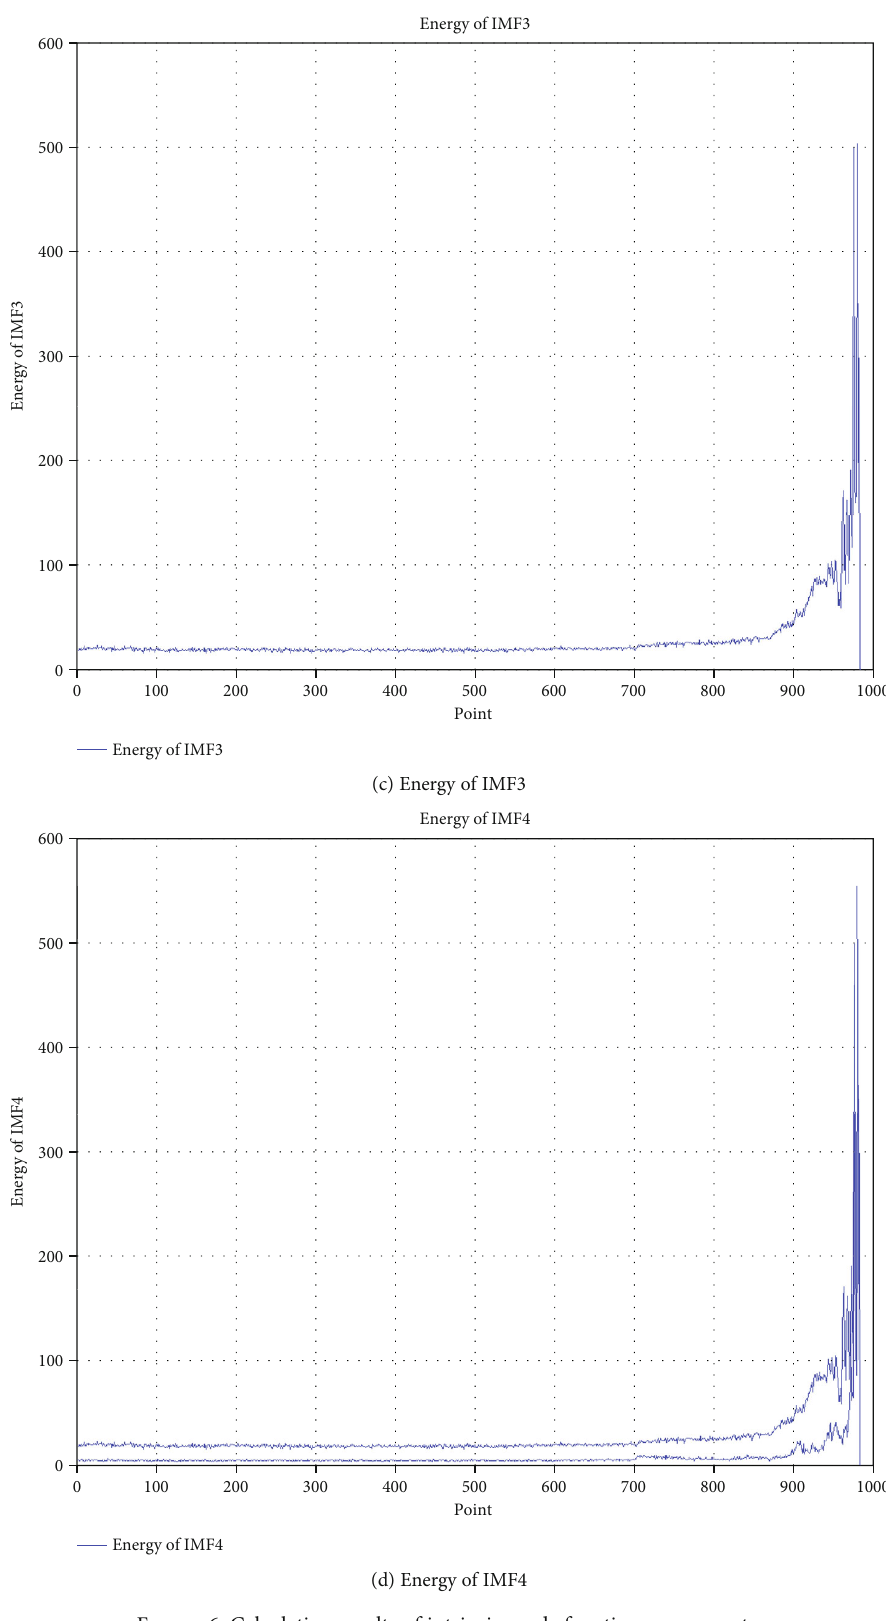
Figure 6: Calculation results of intrinsic mode function